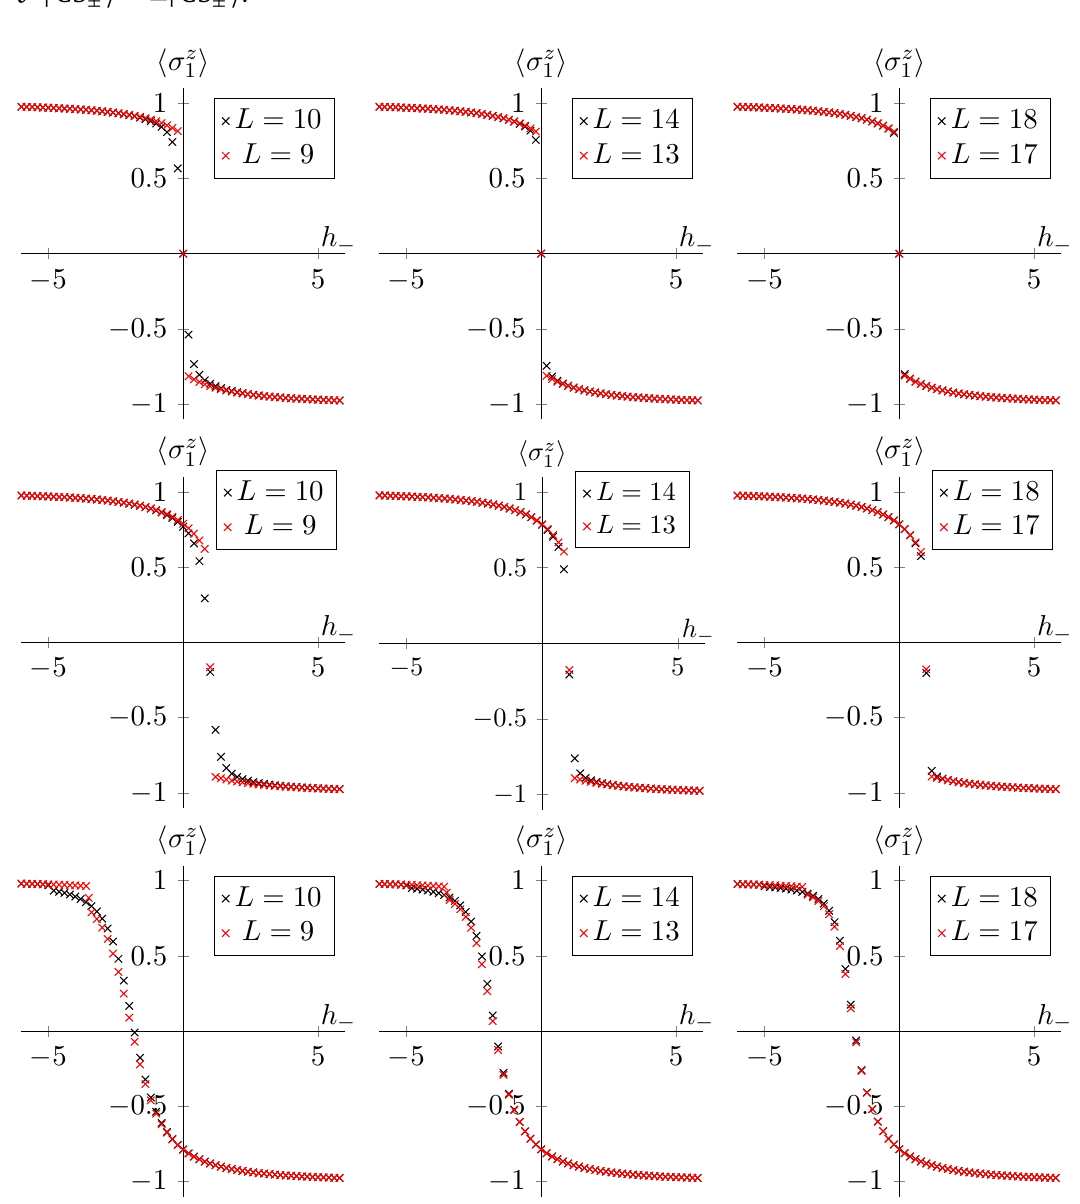
Figure 15: Boundary Magnetization in even and odd-length chains at anisotropy ∆ = 3 in terms of the left boundary field h = h − with fixed right boundary fields h + in the even case, h + = − h in the odd cases. Above : h = 0. Middle : h = 1. Below : h = −